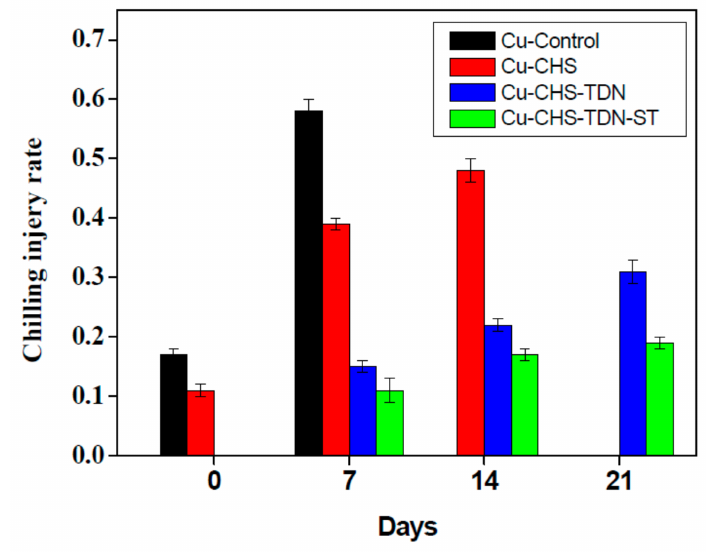
Figure 1. Effect of coating treatments on chilling